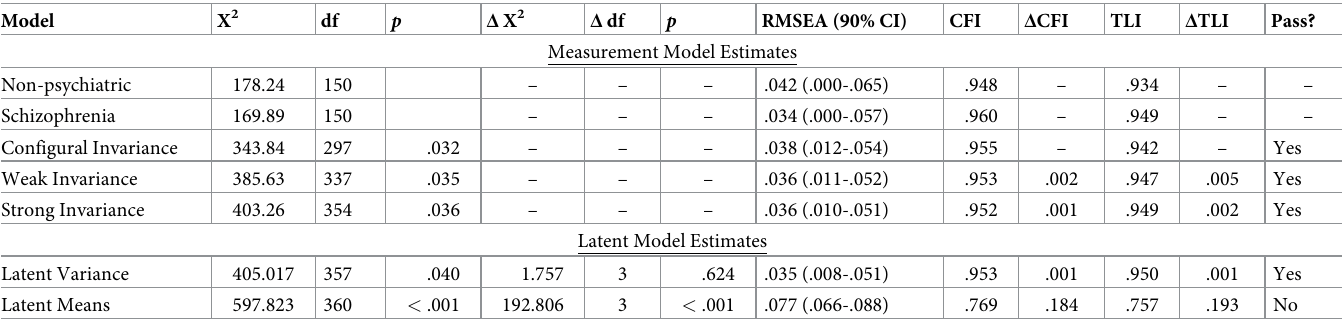
Table 4. Fit statistics for invariance assessment.